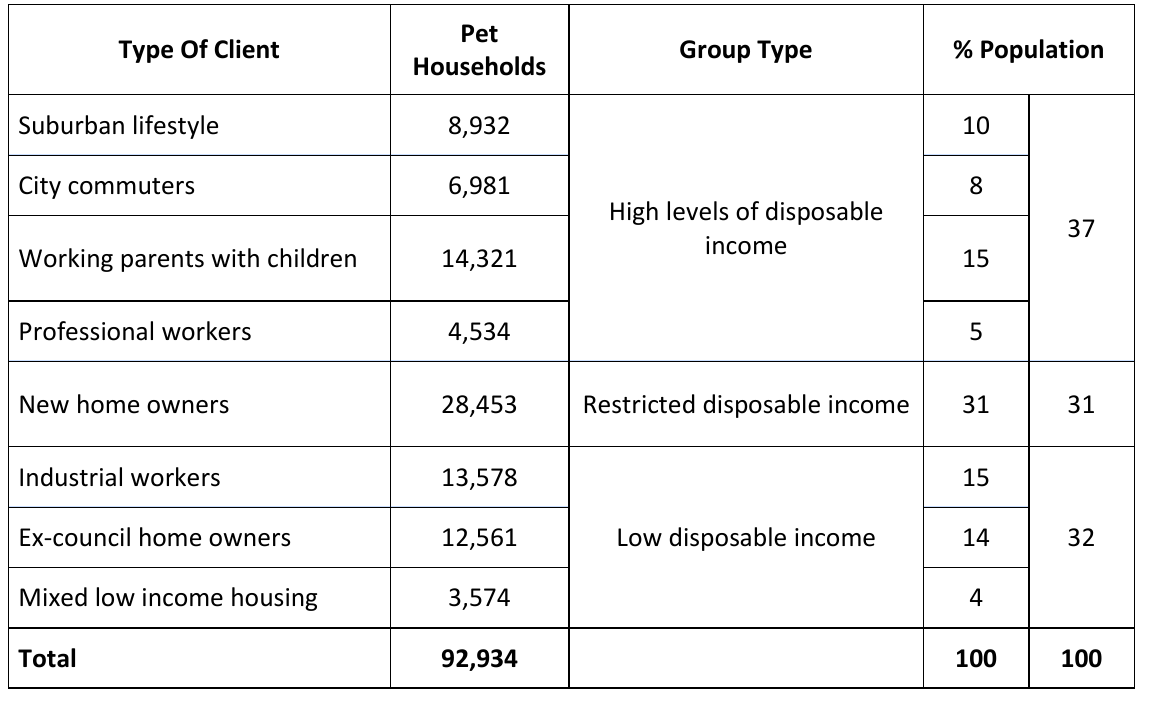
Figure 1. A theoretical Small Animal Sector segmentation of a UK town based on ‘lifestyle’